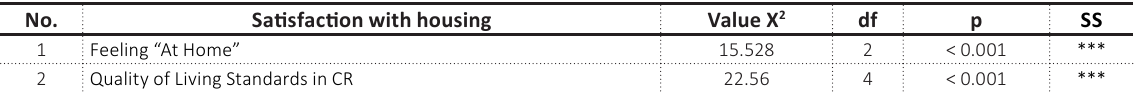
Table 5. Satisfaction with